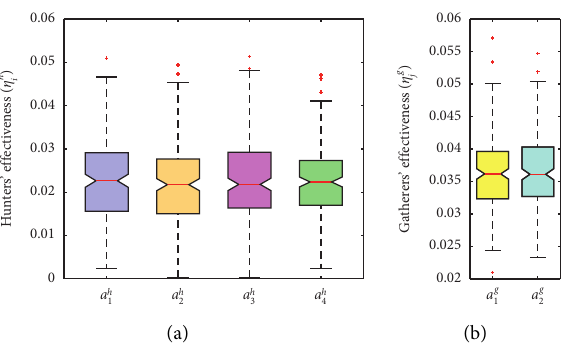
Figure 6: Investigating the fairness of the HGMP for (a) hunter agents and (b) gatherer agents. Statistically, for each type of agent, there is no significant difference in agents’ effectiveness that demonstrates the fairness of the